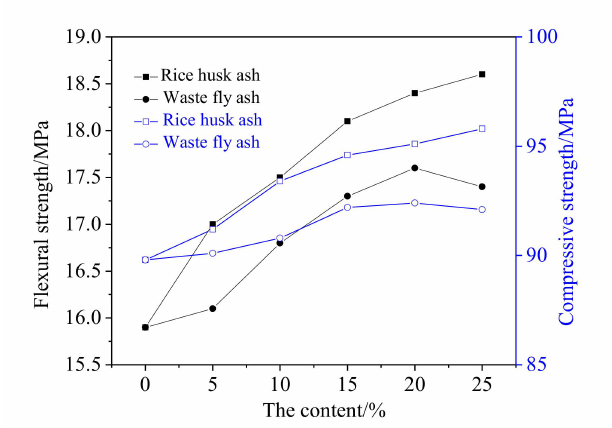
Figure 5. The mechanical strengths of RPC